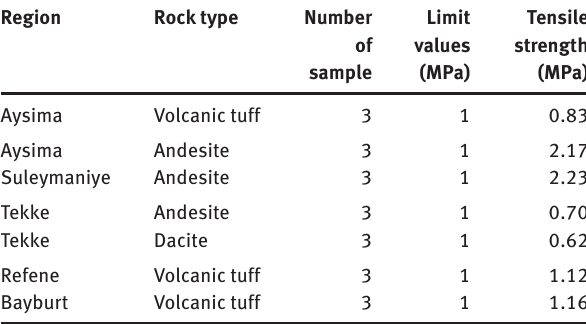
Table 9 Tensile strength values of the samples at the end of 7